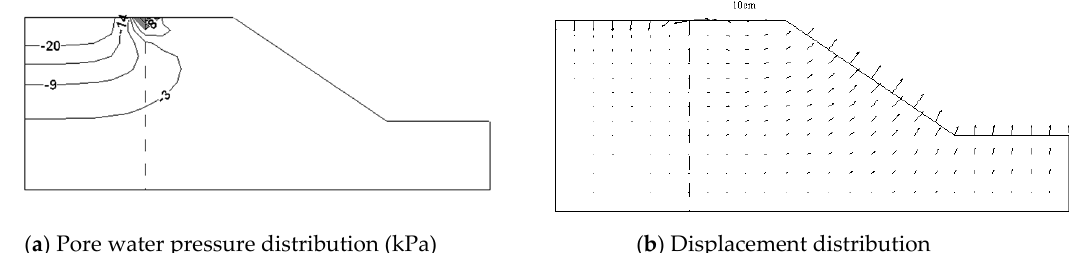
Figure 12. The distributions of pore water pressure and displacement at the end of rainfall with an evaporation rate of 0.1 mm/day.